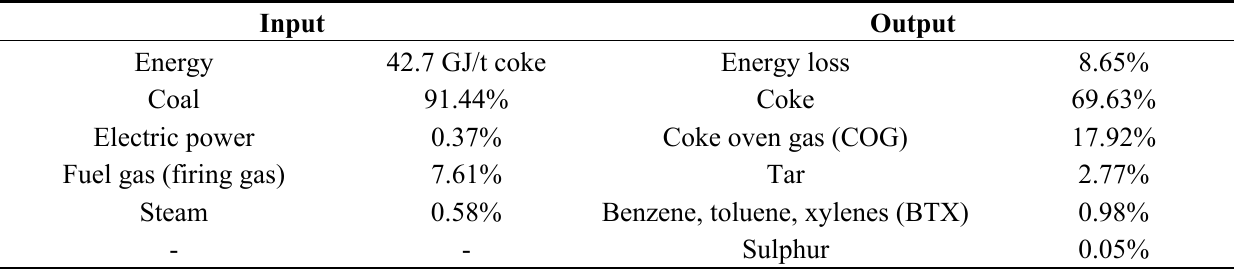
Table 1. Mass and energy flow of a typical coke-making